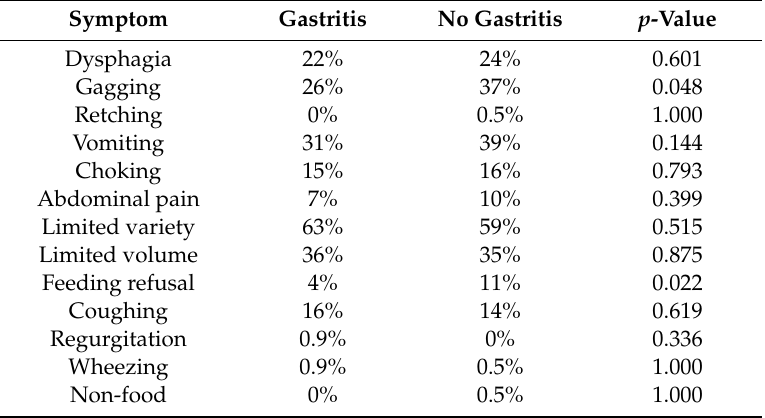
Table 5. Symptom frequencies of patients with and without gastritis.